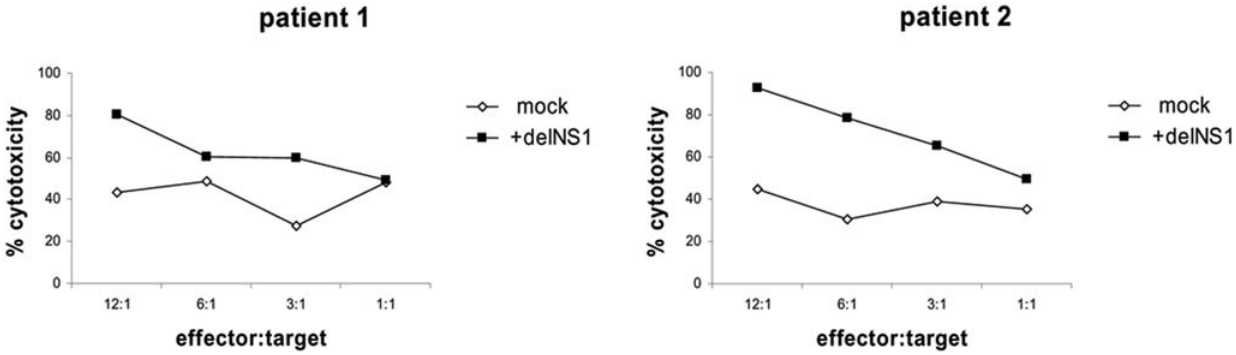
Figure 3. Induction of an anti-tumor cytotoxic immune response by PBMCs derived from patients suffering from medullary thyroid carcinoma. PBMCs were infected with delNS1 virus (m.o.i.=0.02) or mock-treated and incubated for 24 hours. Then the PBMCs were co-cultured with the target A375 cells for 24 hours and cytotoxicity was assessed. Results in percentage of cytotoxicity are shown for two independent experiments.